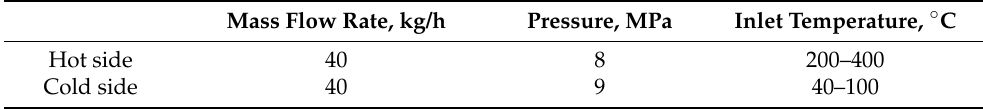
Table 4. Boundary condition parameters for simulation